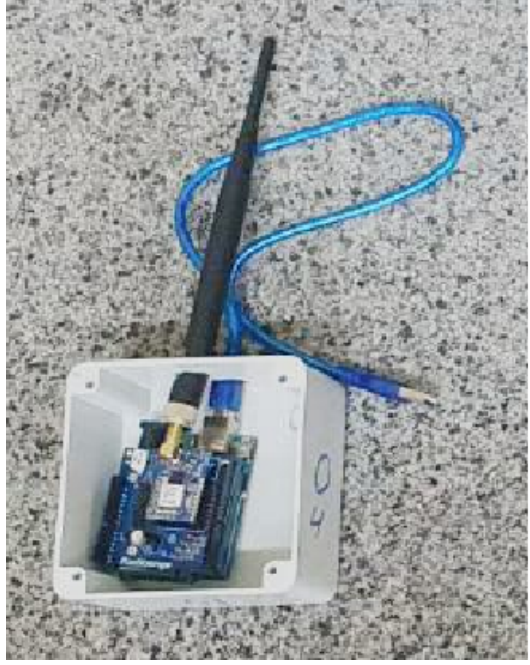
Figure 15. End-node